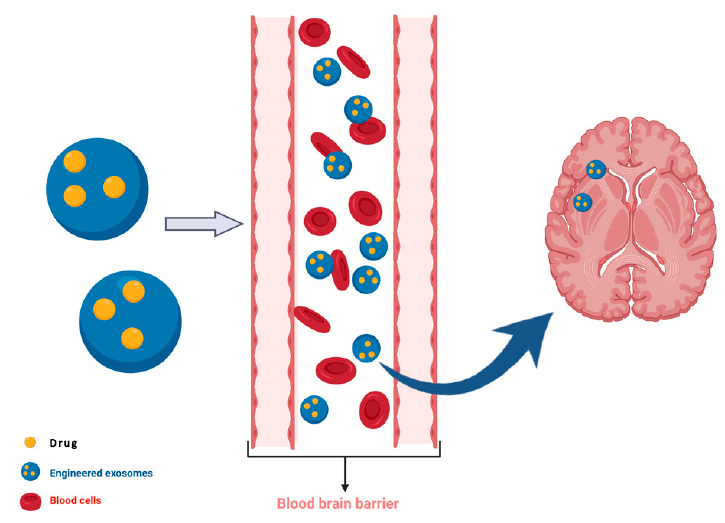
Figure 2. Extracellular vesicles (EVs) could be engineered in order to pass the blood–brain barrier and treat neurodegenerative diseases.